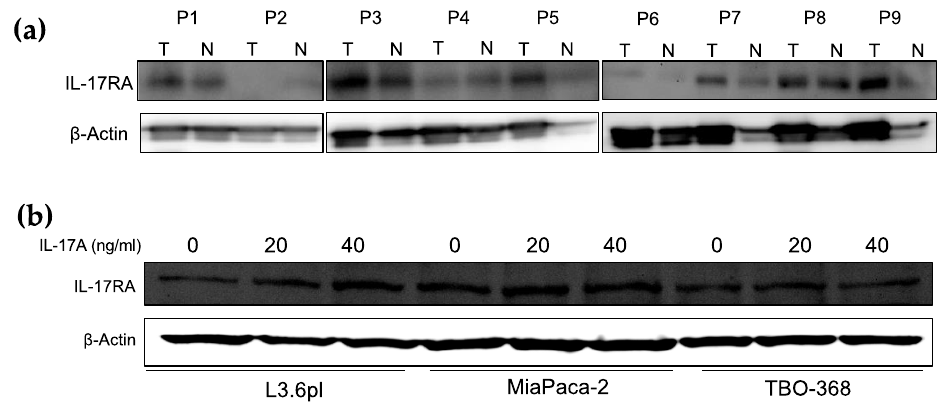
Figure 1. Analysis of IL-17A expression and survival of IL-17A high and low expressing tumors. ( a ) Western blot of IL-17RA protein expression in tumor (T) and corresponding non-tumor tissue (N) from nine human PDAC samples (P1–P9). ( b ) Western blot of IL-17RA protein expression in human PDAC cell lines L3.6pl, MIA PaCa-2, and patient derived PDAC cell line TBO368 with and without IL-17A stimulation (0, 20, 40 ng/mL) for 48 h.